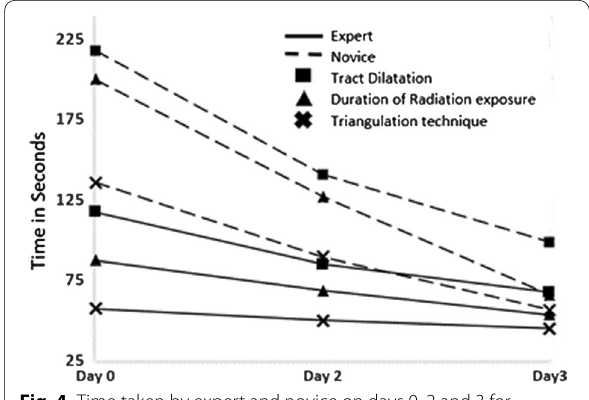
Fig. 4 Time taken by expert and novice on days 0, 2 and 3 for triangulation technique and tract dilatation and duration of radiation exposure during tract dilatation